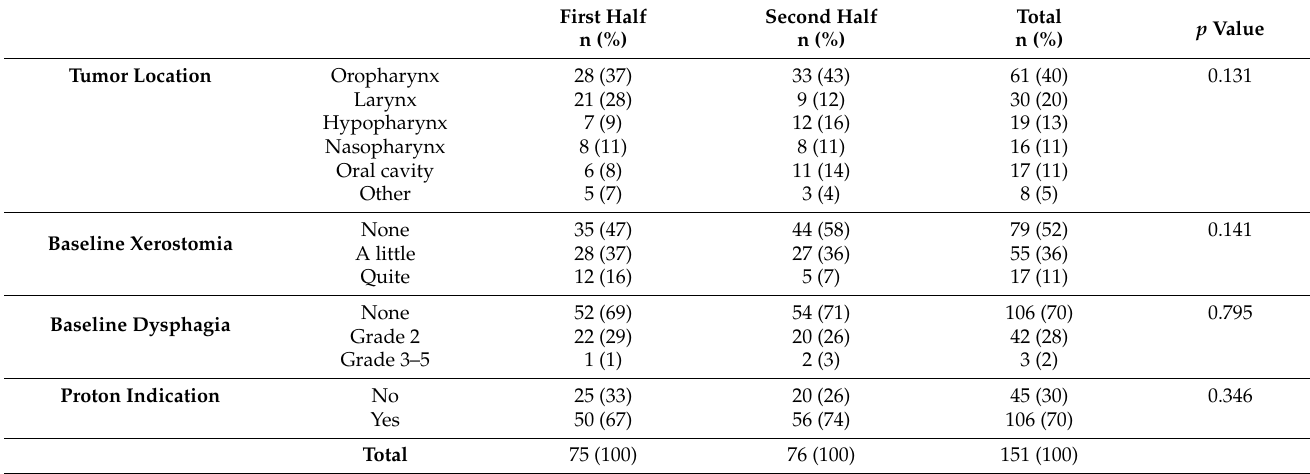
Table A2. Patient characteristics and comparison of the first and second half of the patients based on their treatment initiation